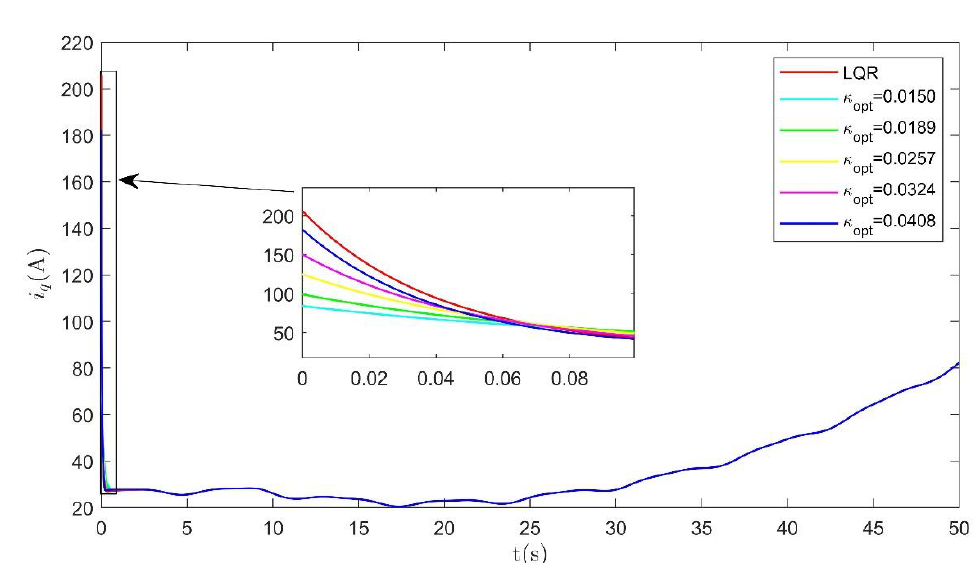
Figure 6. The step tracking control cost curve of the electric tail reduction system.